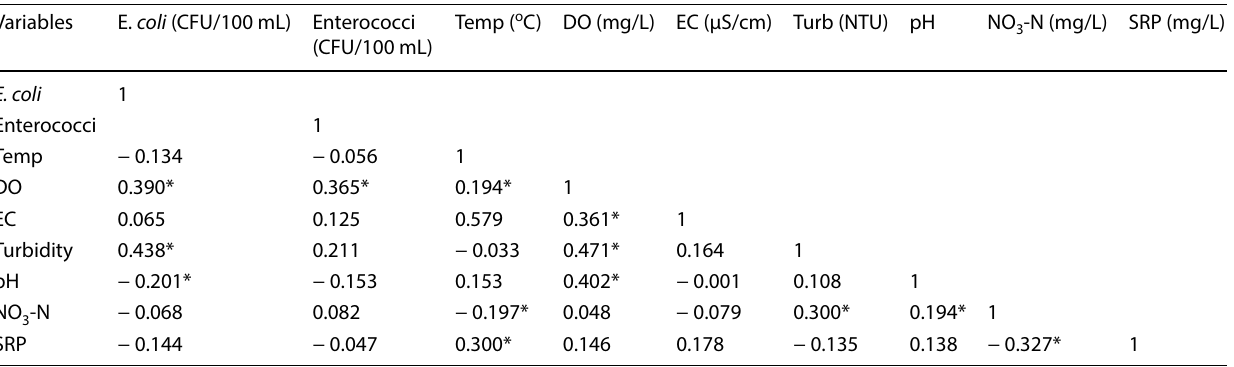
Table 4 Correlation analysis for FIB and environmental parameters; Values with an asterisk are significant at p < 0.05